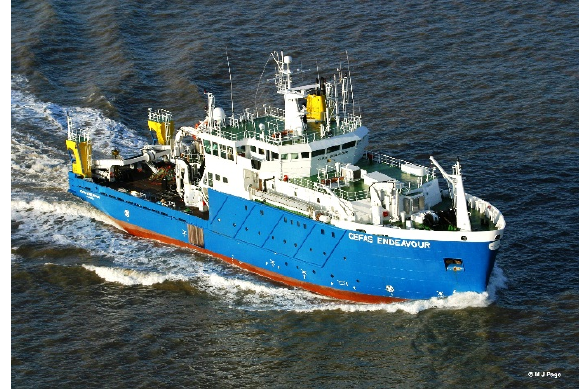
Figure 2. RV Cefas Endeavour 2003 to present.